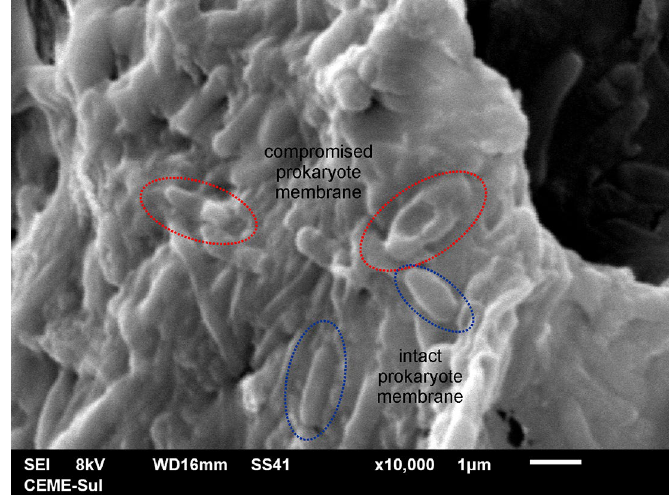
Fig. S1. – Differences between bacteria/archaea intact and compromised cell membranes. Photo from scanning electron microscope (10000×) showing marine prokaryote biofilm on plywood substrate.